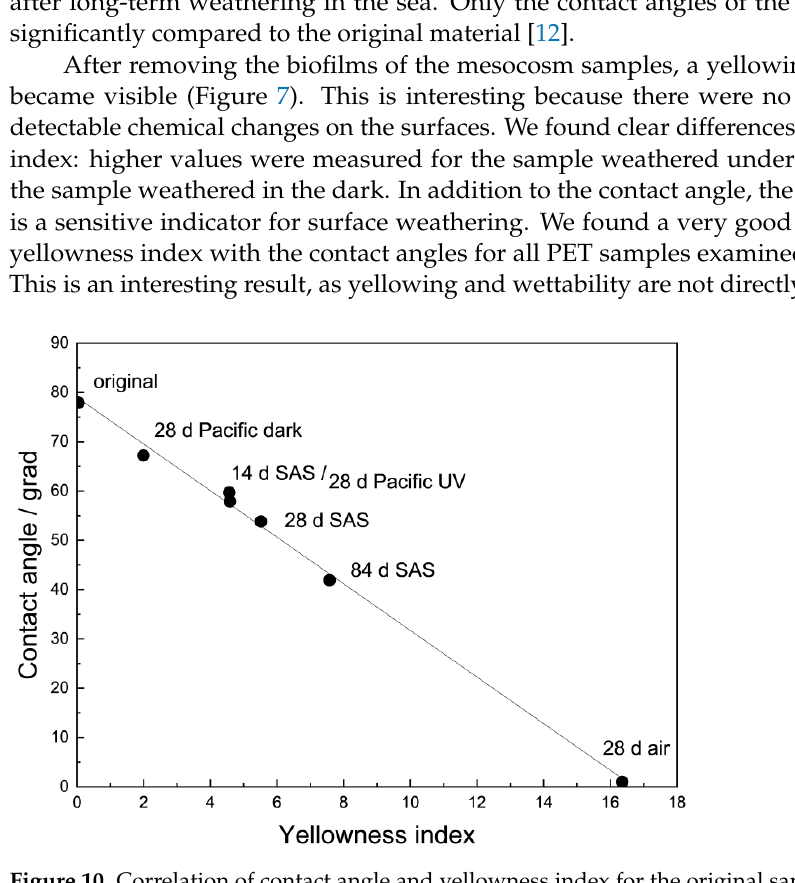
Figure 10. Correlation of contact angle and yellowness index for the original sample and differently weathered PET sheets.